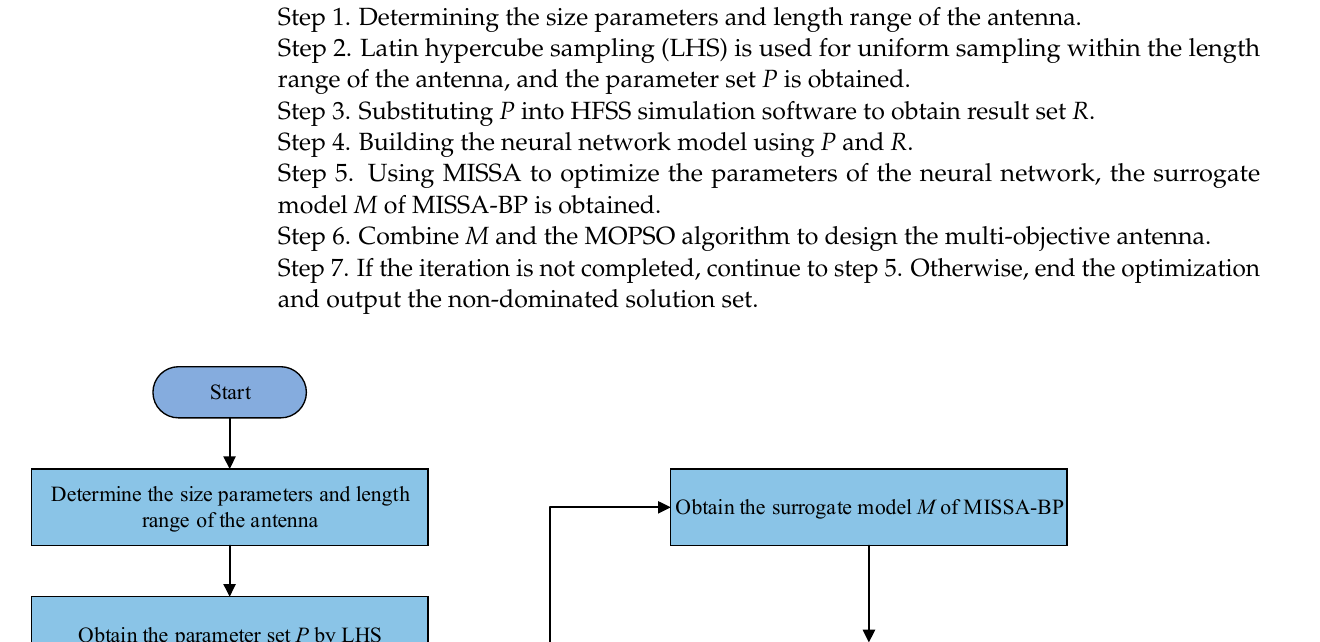
Table 1. Benchmark function.